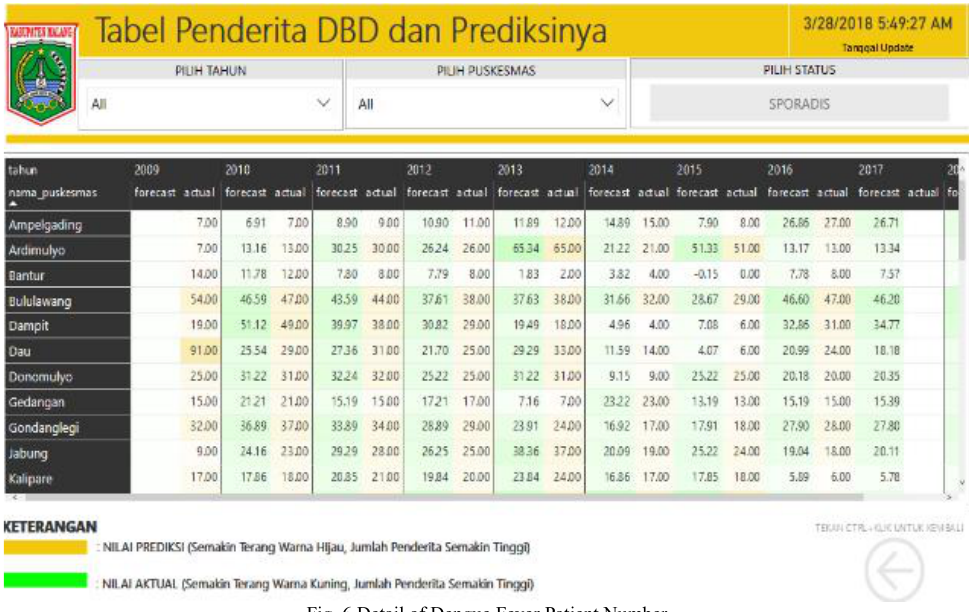
Fig. 6 Detail of Dengue Fever Patient